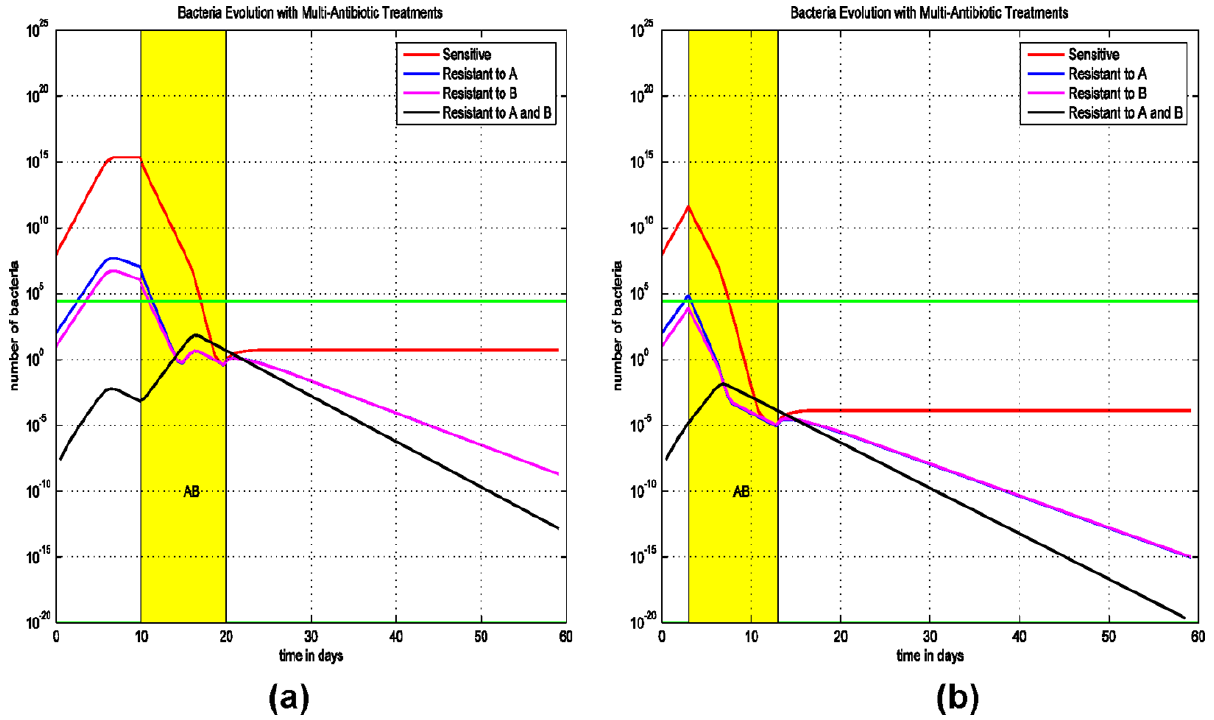
Figure 6. Simulations of Model (3) on early initiation of therapy and evolution of the bacteria population with sensitive and bacteria resistant to antibiotics A and (or) B. (a) A combined therapy with both antibiotics A and B did not start until the 10 th day after the infection. After 10 days, the treatment prevents the progression of the infection. (b) A combined therapy of both antibiotics A and B starts at the 3 rd day after the infection and lasts for 10 days.